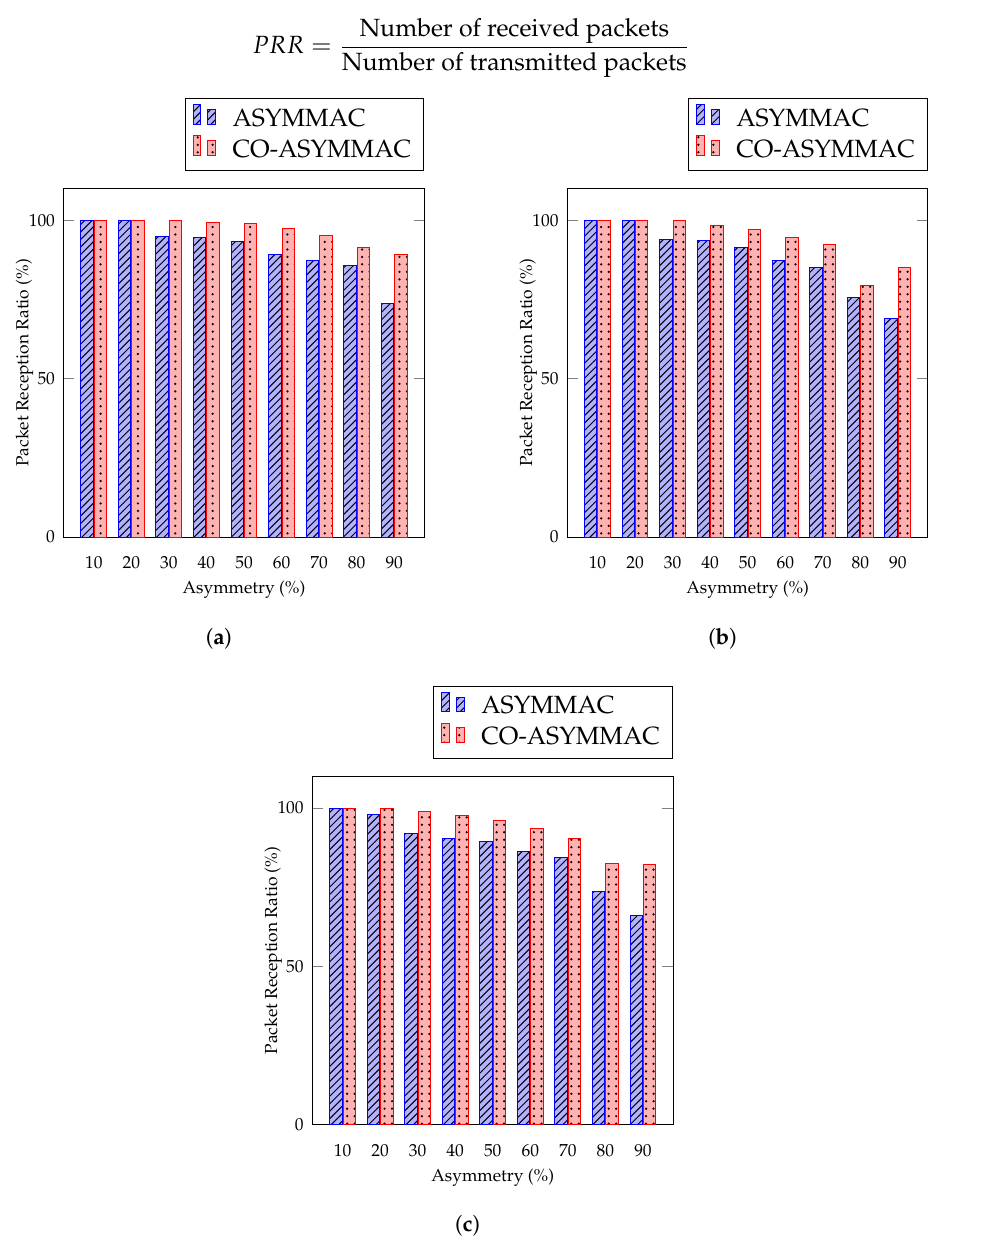
Figure 11. Packet reception ratio: ( a ) for 27 nodes; ( b ) for 54 nodes; and ( c ) for 90